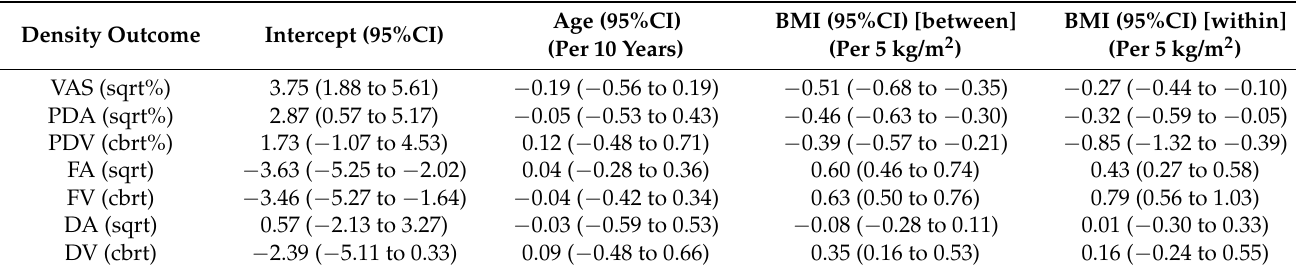
Table 3. Multivariable linear mixed model fit results for mammographic density on body mass index (between and within women), adjusted for age